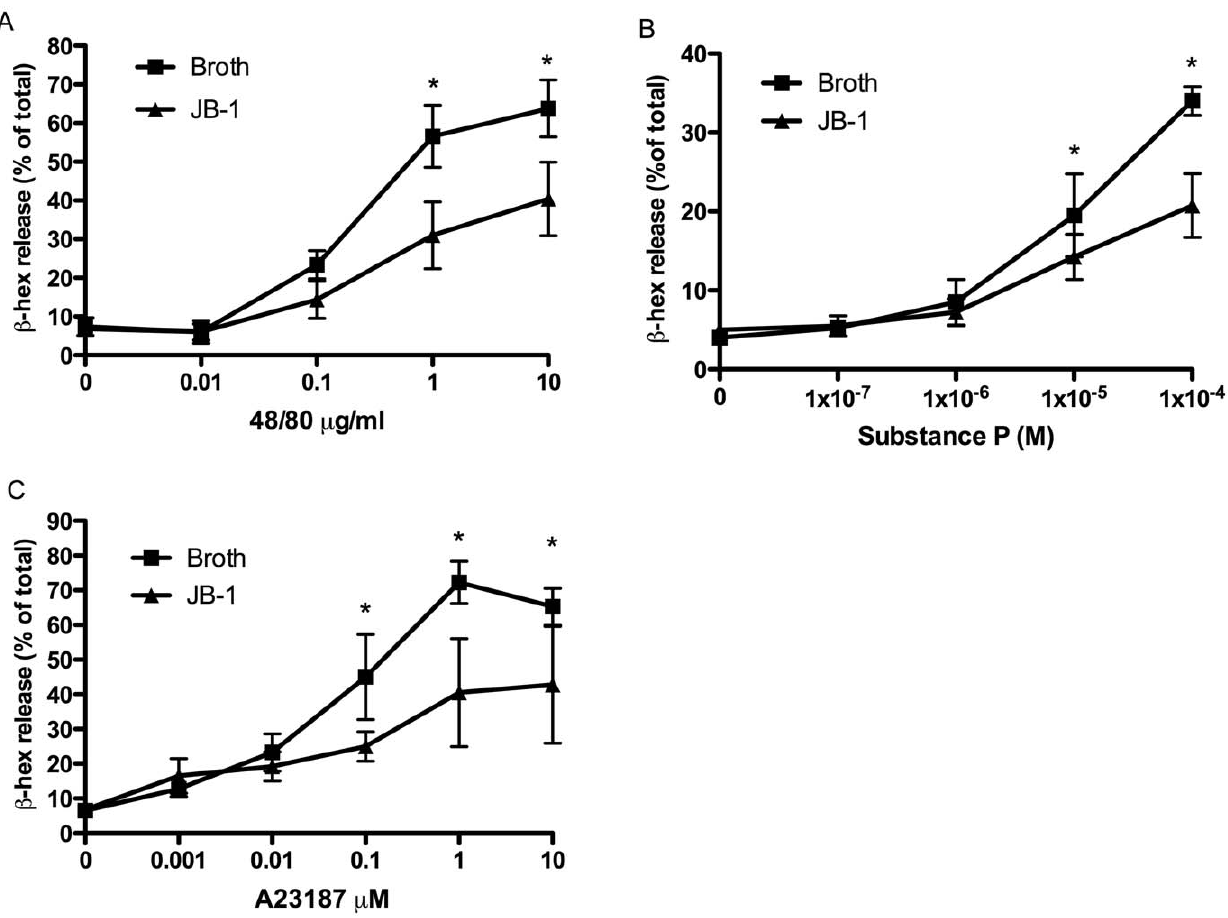
Figure 2. b -hexosaminidase release from rat peritoneal mast cells isolated following 9 days oral treatment with MRS (Broth) or L.rhamnosus JB-1 (JB-1) in response to 48/80 (A), Substance P (B) and A23187 (C). b -hexosaminidase is expressed as percentage of total b - hexosaminidase in the cells. Data is presented as mean 6 SD, n=6 in each treatment group, 3 independent experiments *=p,0.05.